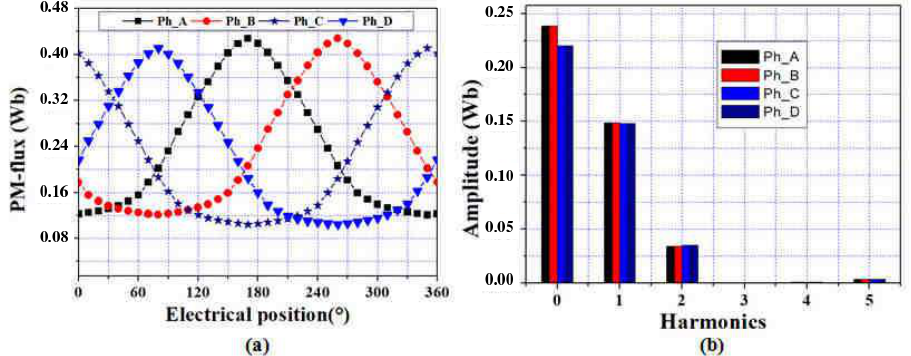
Figure 10. PM-flux and FFT spectra of 4-phase with four coils/phase: ( a ) PM-flux, ( b ) FFT